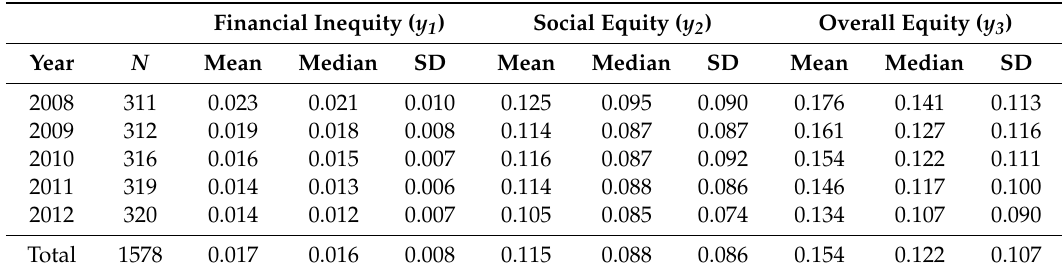
Table 2. Distribution of equity indicators (2008–2012).